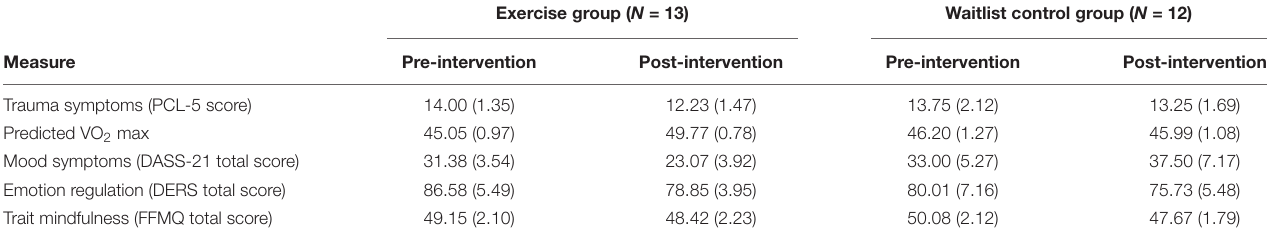
Scores are presented as Mean (Standard error).